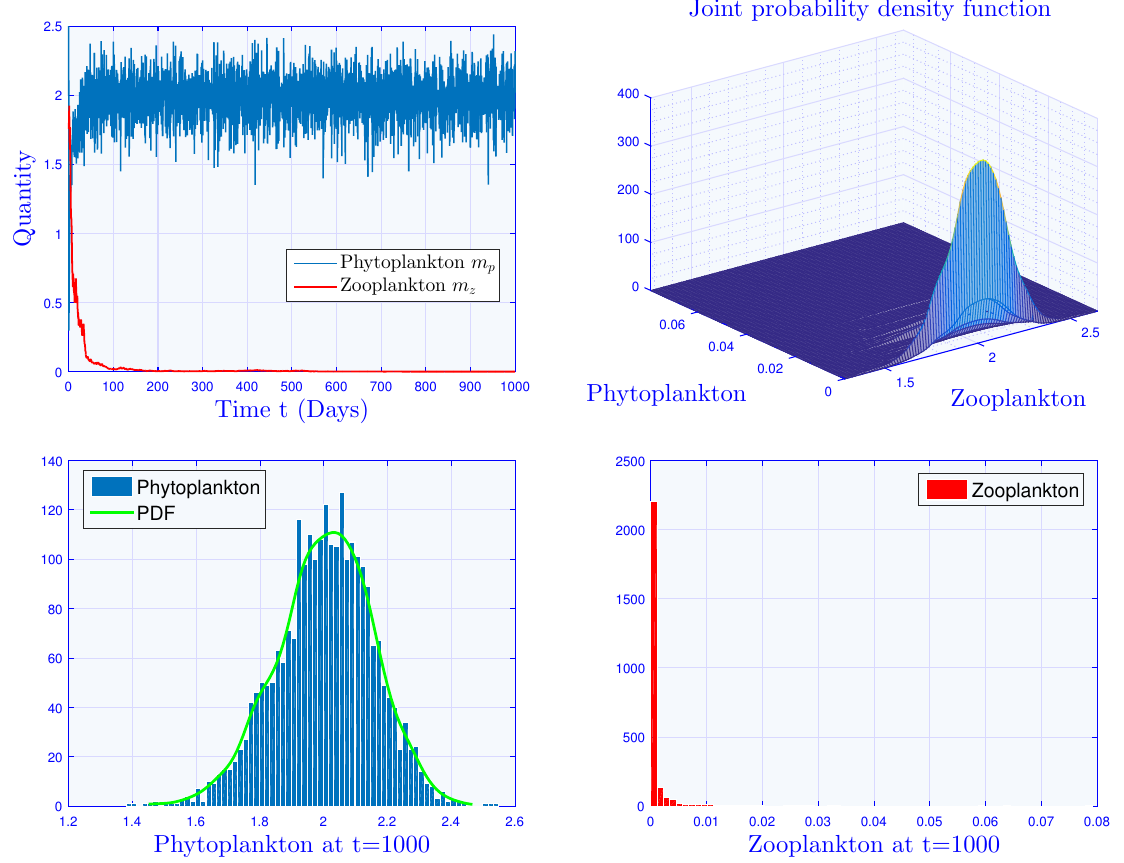
Figure 5. Line 1: trajectories of quantities ( m p , m z ) and their associated joint probability density function π Σ ( m p , m z ) . Line 2: the projection drawing of π Σ on the associated marginal planes (marginal densities). The fixed deterministic coefficients are chosen from Table 1 (Test 2). For random amplitudes, we select Υ 00 = 0.17, Υ 01 = 0.1, Υ 02 = 0.001, Υ 10 = 0.13, Υ 11 = 0.112, Υ 12 = 0.001, Ξ ( r ) = 0.1, Ξ ( r ) = 0.01, Ξ ( r ) = 0.1, Ξ ( r ) = 0.01. In this case, S m = − 0.0074 < 00 01 10 11 0